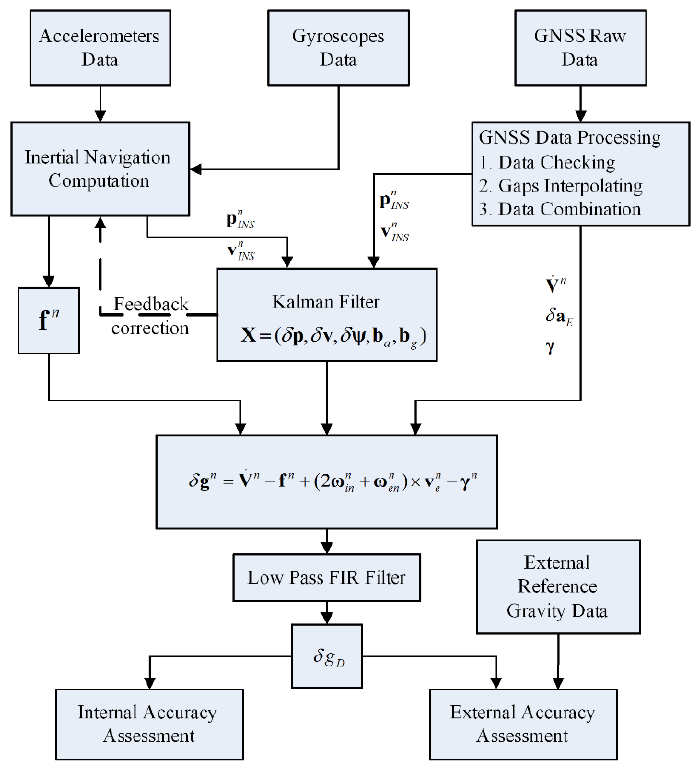
Figure 10. Data processing flow